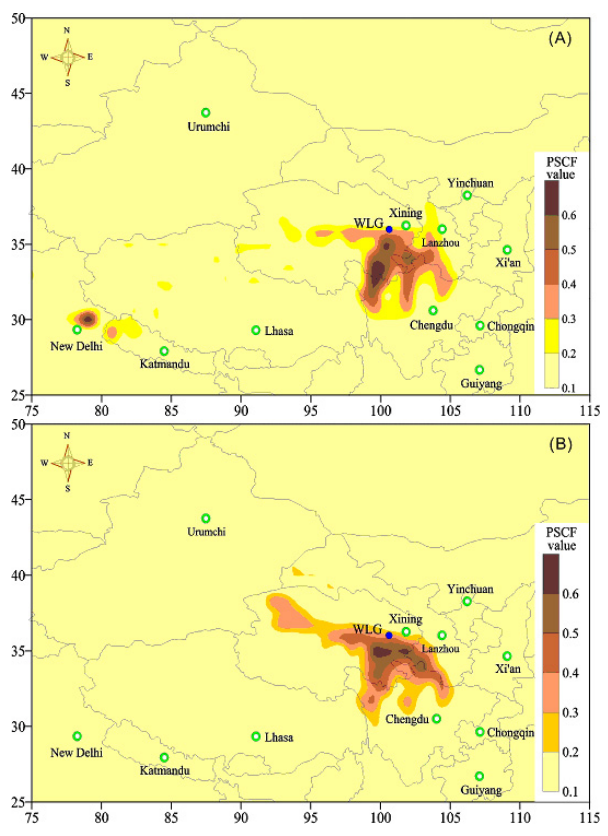
Fig. 7. Likely source areas of (A) PBM and (B) GOM identified using Potential Source Contribution Function (PSCF) plots.